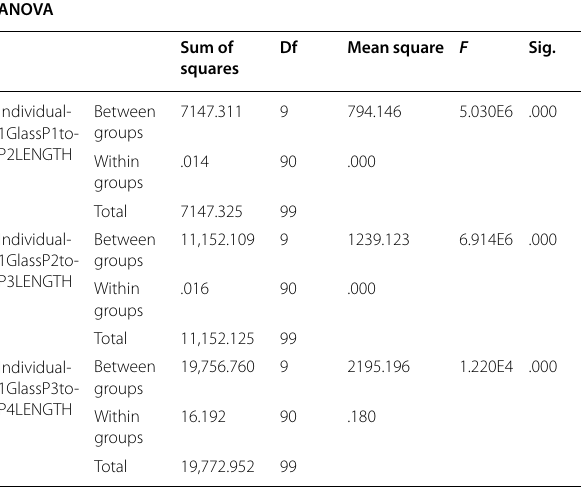
Table 8 Results obtained using ANOVA for fingerprints obtained from the left thumb of individual 1 on glass with “center-to- center length” as the “dependent variable”